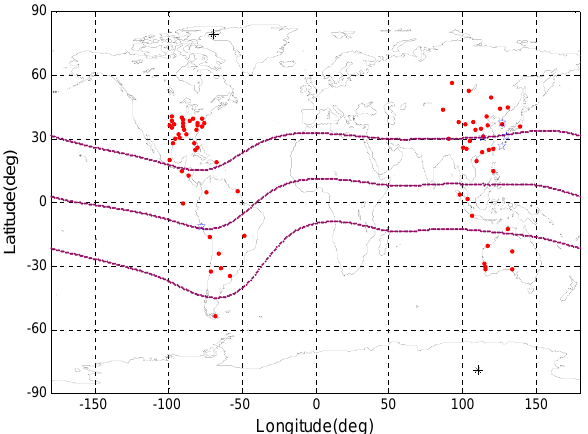
Fig. 2. The dots show the geographic distribution of GPS receivers Fig. 2 . The dots show the geographic distribution of GPS receivers that used in our TEC that were used in our TEC calculation. The dashed lines denote dip calculation. The dashed line denotes dip latitudes 45°, 0° and -45°. The Five-pointed star marks latitudes 45 ◦ , 0 ◦ and − 45 ◦ . The five-pointed star marks the location the location of ionosonde station. The ‘*’ denotes location where magnetic pole locates. of the ionosonde station. The “*” denotes the location where the magnetic pole